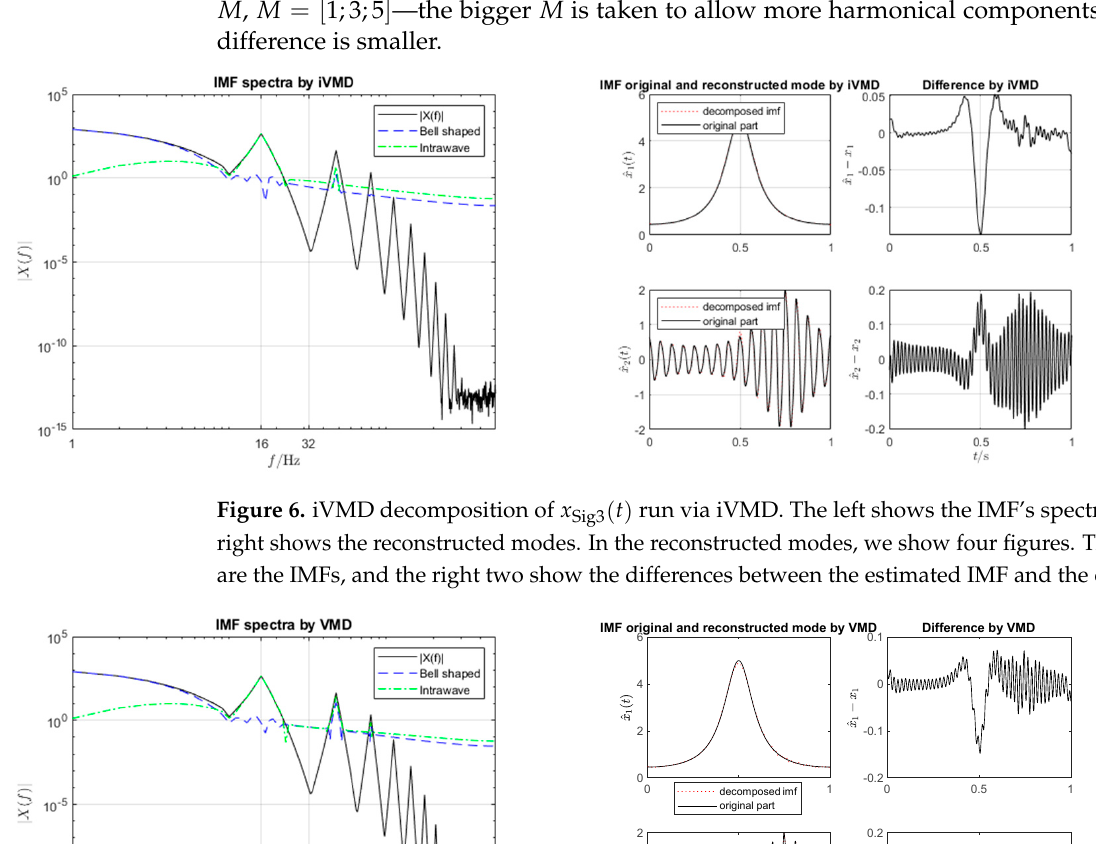
Figure 5. VMD decomposition of 𝑥 (cid:2903)(cid:2919)(cid:2917)(cid:2870) (𝑡) .